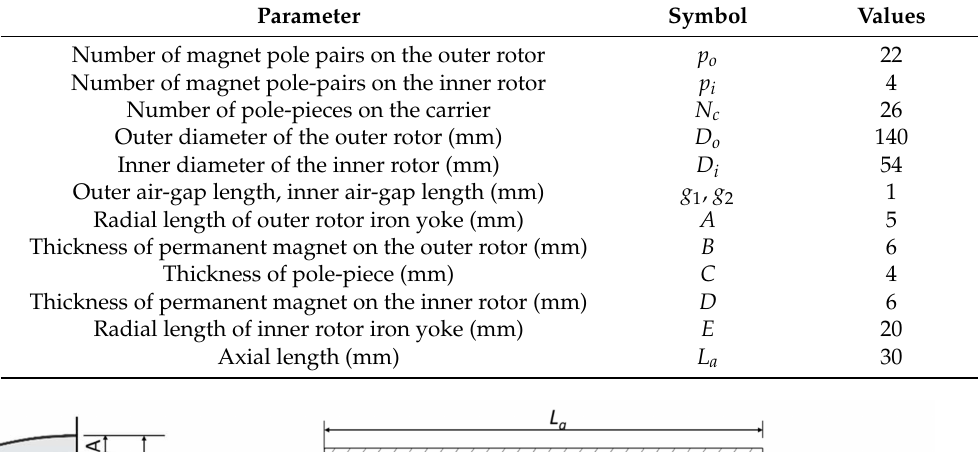
Table 2. Preliminary design parameters of a CMGT.